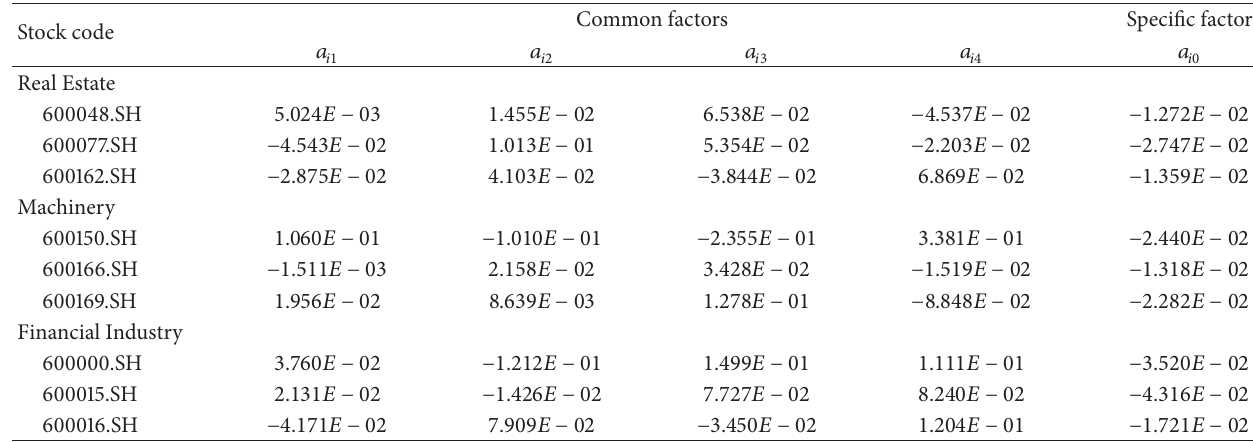
Table 2: Coefficients of the factors in mixed Poisson